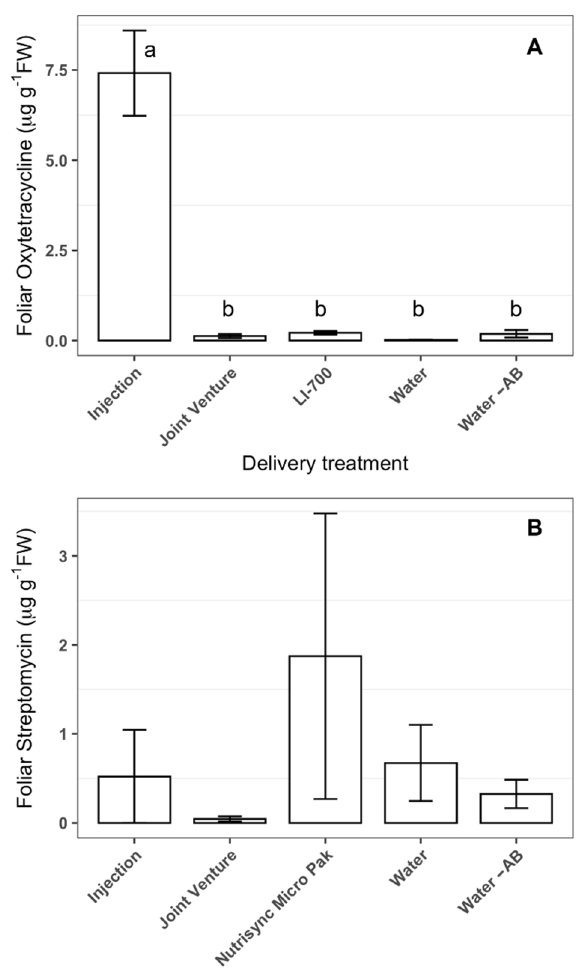
Figure 2. Concentrations of systemically delivered streptomycin ( A ) and oxytetracycline ( B ) in leaves of ‘Hamlin’ sweet orange ( C. × sinensis ) two days after delivery by the foliar application using various adjuvants or the trunk injection. Values are concentrations in leaves that were covered to protect them from direct contact with foliar sprays. The application dose was 0.78 g streptomycin per tree or 0.72 g of oxytetracycline per tree. Bars represent means and error bars represent standard error ( n = 12). Treatments with different letters (a, b) are significantly different using Bonferroni’s protected least significant differences ( p < 0.05). Bars not labeled with letters indicate that the treatment effect was not significant according to an analysis of variance. AB: anti-bacterial compound.